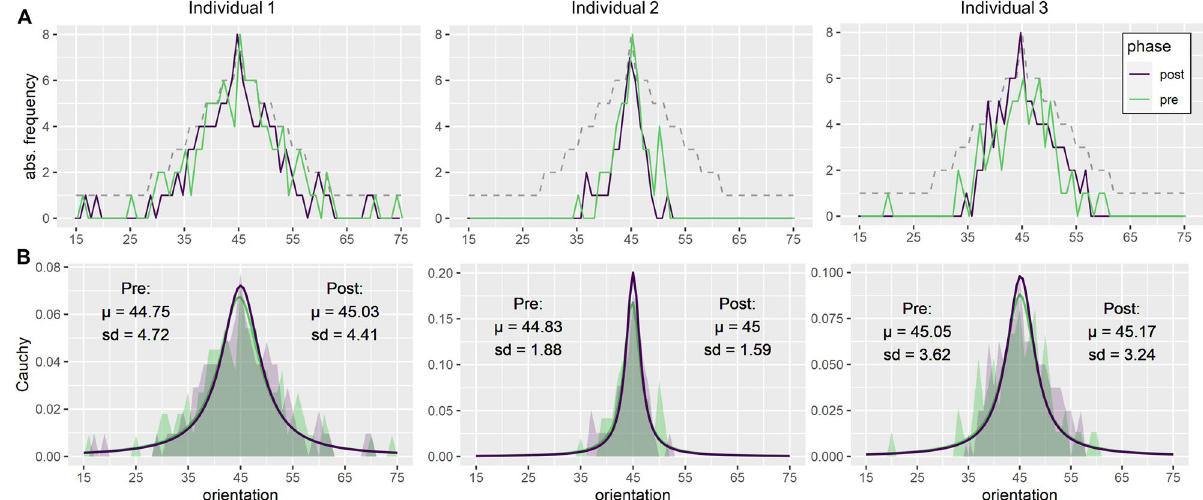
Figure 2. ( A ) Three examples of individual response data from the visual discrimination task. The green and purple lines represent the sum of ‘identical’-responses per condition during the pre- and post-task, respectively. The dotted line depicts the number of total presentations per condition. ( B ) Bold lines show the fitted Cauchy- distributions over the behavioral response data (shaded areas) prior and after associative learning. The extracted means (µ) and standard deviations (SD) are noted in the